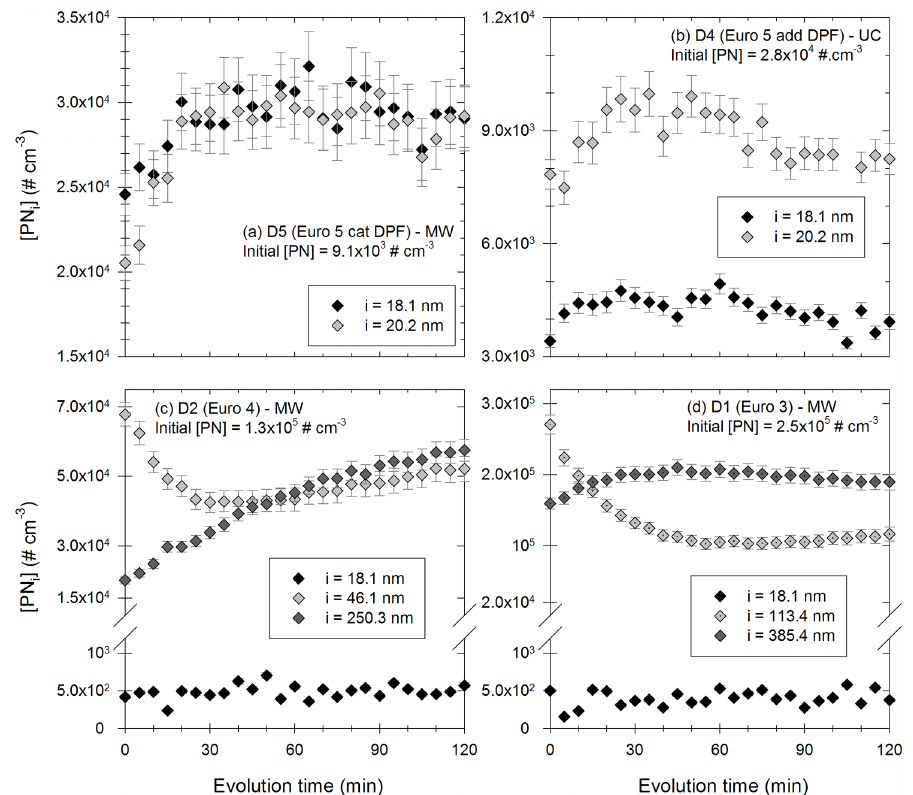
Figure 10. Evolution with time of the particles [PN i ] in certain diameter bins during 2h. Panels (a) and (b) show particles in the bins 18.1nm (black) and 20.2nm (light grey) for experiments with vehicle D5 under MW conditions with an initial [PN] of 9.1 × 10 3 cm − 3 and with vehicle D4 under UC conditions with an initial [PN] of 2.8 × 10 4 cm − 3 , respectively. Panel (c) shows particles in the bins 18.1nm (black), 46.1nm (light grey) and 250.3nm (dark grey) with vehicle D2 under MW conditions with an initial [PN] of 1.3 × 10 5 cm − 3 . Panel (d) shows particles in the bins 18.1nm (black), 113.4nm (light grey) and 385.4nm (dark grey) with vehicle D1 under MW conditions with an initial [PN] of 2.5 × 10 5 cm − 3